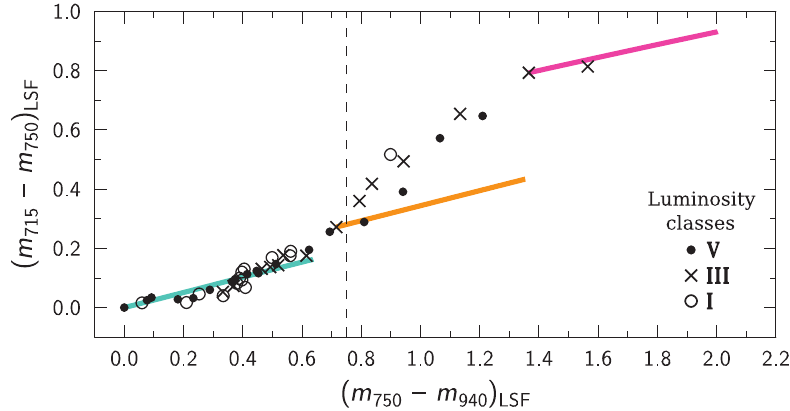
Fig. 9. The contaminated diagram m 715 (cid:0) m 750 vs. m 750 (cid:0) m 940 for the identification of M-type stars. Reddening lines for the O8 V, K5 III and M5 III stars up to A V = 3 mag are shown. The vertical broken line separates M-type stars from the remaining without interstellar